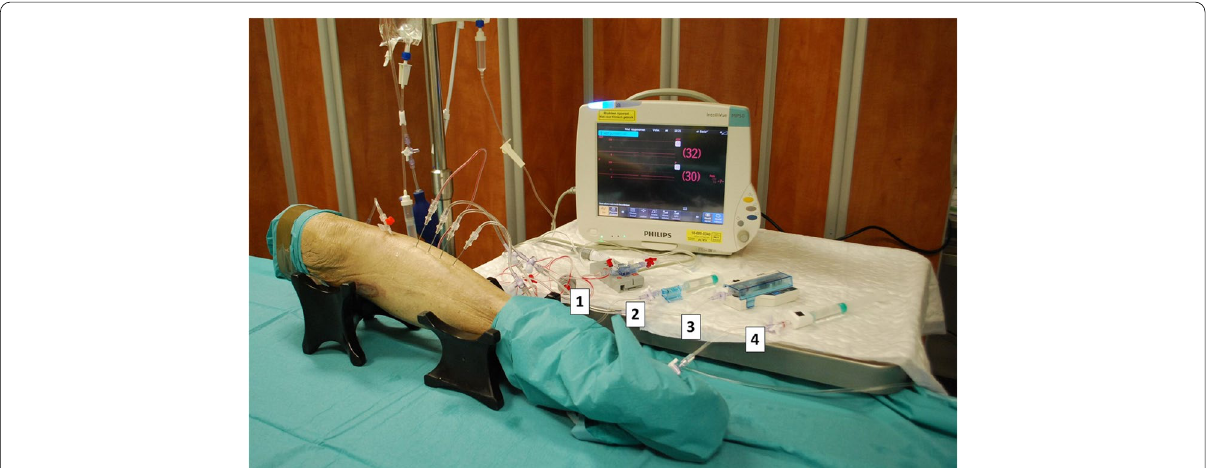
Fig. 3 Example of a limb with the experimental setup installed, using the Stryker side‑ported needle. The four different terminal devices are: 1. Xtrans ® system; CODAN, Lensahn, Germany & IntelliVue MX500 monitor; Philips, Eindhoven, the Netherlands, 2. Meritrans DTXPlus ® Disposable Transducers; Merit Medical Systems, Jordan, Utah & IntelliVue MX500 monitor; Philips, Eindhoven, the Netherlands, 3. Stryker Intracompartmental Pressure Monitor System; Stryker, Kalamazoo, Michigan, 4. Compass UniversalHg; Iskus Health, Ltd., Dublin,